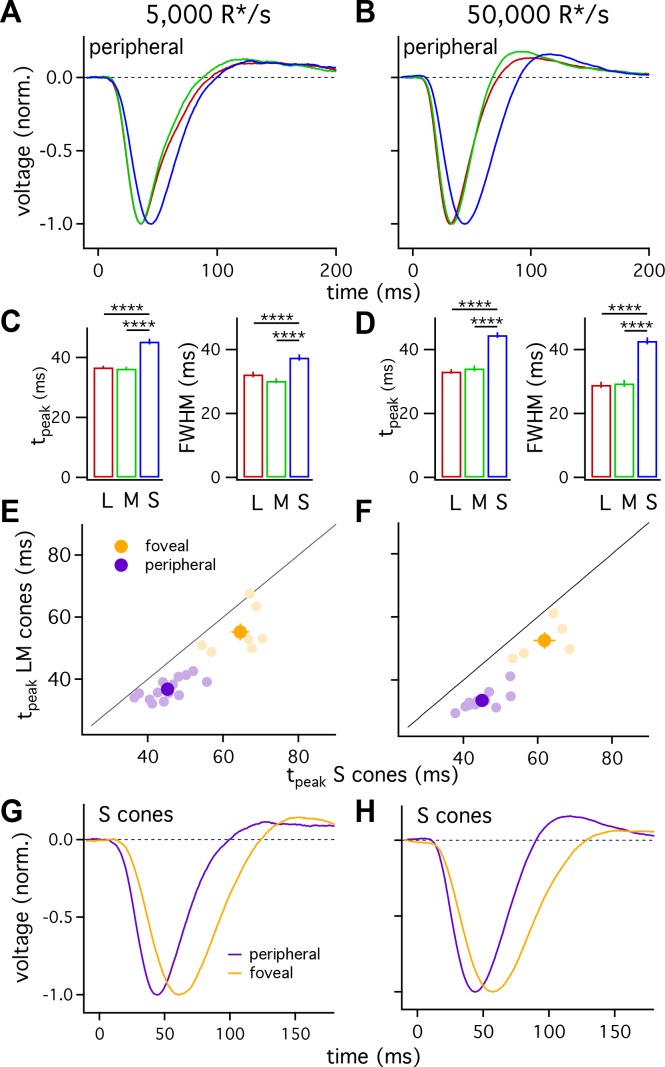
S cones are slower than L and M cones across retinal eccentricities.(A) Average normalized voltage responses of L, M and S cones on a background of 5000 R*/s. These averages, unlike those in Figure 1, include only cells from scatter plots in E. Data in this figure is collected from >10 peripheral retinae and >= 5 foveae. (B) As in A for data collected on a background of 50,000 R*/s. Only cells from scatter plots in F are included. (C) Times to peak (left) and full-width-at-half-maximum (FWHM, right) across cone types at a background of 5000 R*/s. The mean ± sem times to peak were 36.7 ± 0.6 ms for L cones (n = 49), 36.3 ± 0.6 ms for M cones (n = 26), and 45.3 ± 0.9 ms for S cones (n = 36). p-Values from unpaired t-test. For the same cones, mean ±sem of the FWHM was 37.5 ± 1 ms for S cones, 30.2 ± 0.8 ms for M cones and 32.2 ± 0.9 ms for L cones. **** denotes p<0.0001. (D) Times to peak and FWHM as in C at 50,000 R*/s. The mean ± sem times to peak were 33.1 ± 0.7 ms for L cones (n = 42), 34.1 ± 0.9 ms for M cones (n = 17), and 44.5 ± 0.9 ms for S cones (n = 28). For the same cones, mean ±sem of the FWHM was 42.7 ± 1.1 ms for S cones, 29.4 ± 1.1 ms for M cones and 29.0 ± 1.0 ms for L cones). (E) Average time to peak of S cones compared to average time to peak of pooled L and M cones in peripheral (purple) and foveal (gold) retina on a background of 5000 R*/s. Each lightly shaded point represents the average time to peak from a single piece of retina (15 peripheral and seven foveal pieces; peripheral cells are those from A and C; foveal data comprises 29 S cones, 24 M cones and 25 L cones). Dark points with error bars represent the mean ±sem across all pieces at a given eccentricity. S cones are significantly slower than their LM counterparts in peripheral (p<10−6, paired t-test) and foveal (p<0.05, paired t-test) retina. (F) As in E, for data collected on a background of 50,000 R*/s. Peripheral (p<10−6, paired t-test) and foveal (p<0.05, paired t-test) S cones were significantly slower than their LM counterparts (11 peripheral pieces, five foveas; peripheral cells are those from B and D; foveal data comprises 21 S cones, 8 M cones, and 12 L cones). (G) Average S-cone flash responses from peripheral and foveal retina on a background of 5,000 R*/s. Times to peak of 63.5 ± 1.8 ms for 29 foveal S cones and 45.3 ± 0.9 ms for 36 peripheral S cones. (H) As in (G) on a background of 50,000 R*/s. Times to peak of 59.1 ± 2.1 ms for 21 foveal S cones and 44.5 ± 0.9 ms for 28 peripheral S cones.